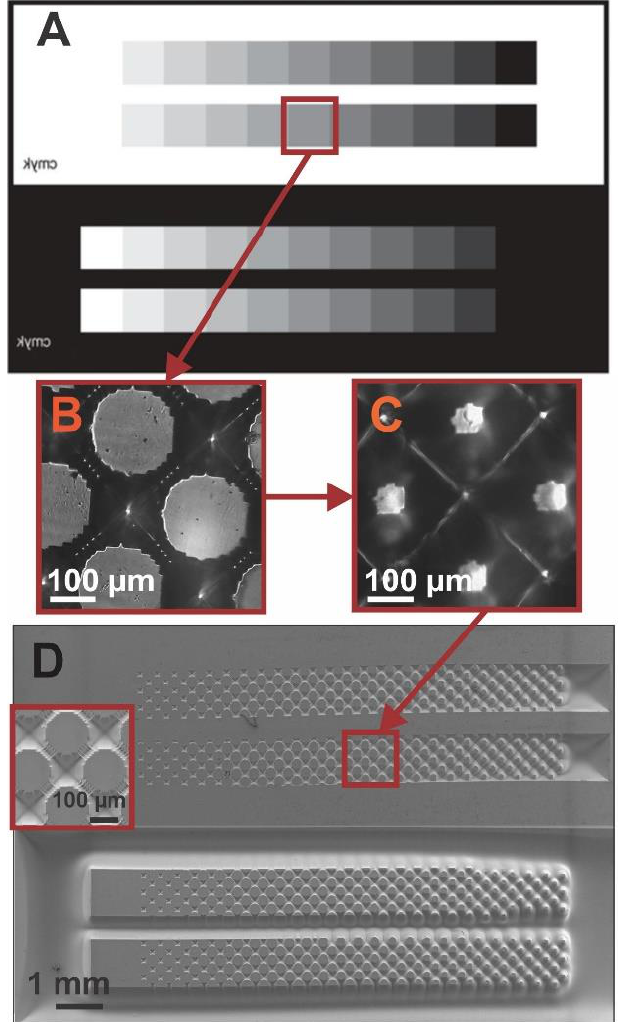
Figure 2. ( A ) Design of the grayscale mask used. ( B ) Optical image of the resulting pattern in the photopolymer flexographic mold (Fmold). ( C ) Optical image of the resulting pattern in the epoxy resin mold (ER mold). ( D ) SEM image of the PDMS stamp. The inlet shows a magnification of the respective pattern obtained with the mask.